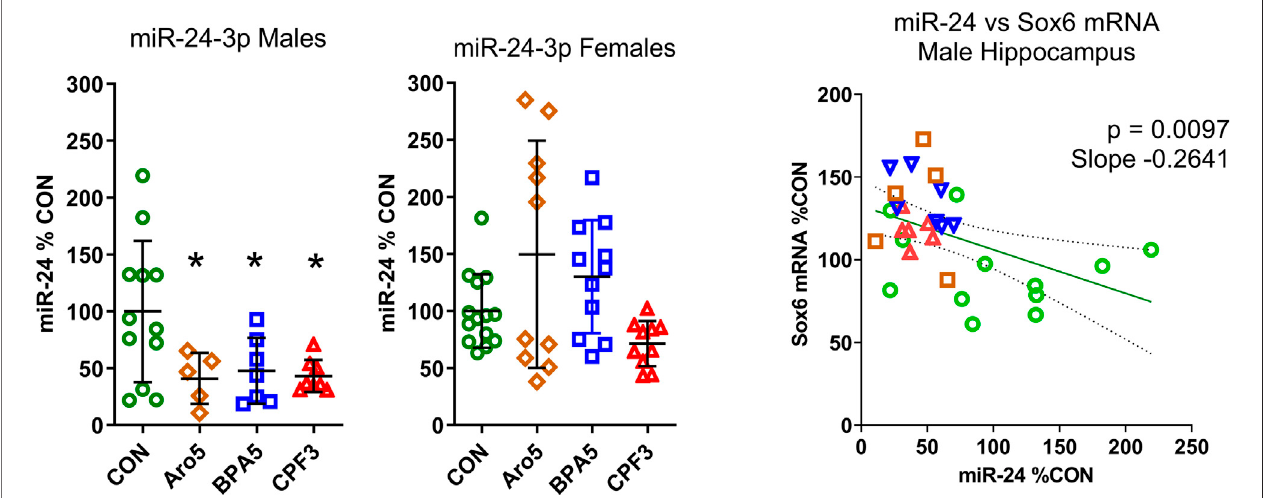
FIGURE 4 | A. Level of miR-24-3p in hippocampus of male and female rat offspring at postnatal day 6 after pre- and postnatal administration of Aroclor 1254 (5 mg/kg, Aro5), bisphenol A(5 mg/kg, BPA5), or chlorpyrifos (3 mg/kg, CPF3). Quantitative RTPCR,individual values withmean ± S.D, * p < 0.05 differentfrom control group. CON: controls, ARO5:Aroclor1254, 5 mg/kg, BPA5:bisphenolA,5 mg/kg, CPF3: chlorpyrifos3 mg/kg. B.RelationshipbetweenmiR-24-3p (%ofcontrol) and Sox6 mRNA (% of control, real time RT PCR) in individual hippocampus samples of male offspring. Inverse correlation, p (cid:1) 0.0097, r (cid:1) − 0.4645, slope (cid:1) − 0.264. Green symbols: control, brown: Aroclor 1254 5 mg/kg, blue: bisphenol A 5 mg/kg, red: chlorpyrifos 3